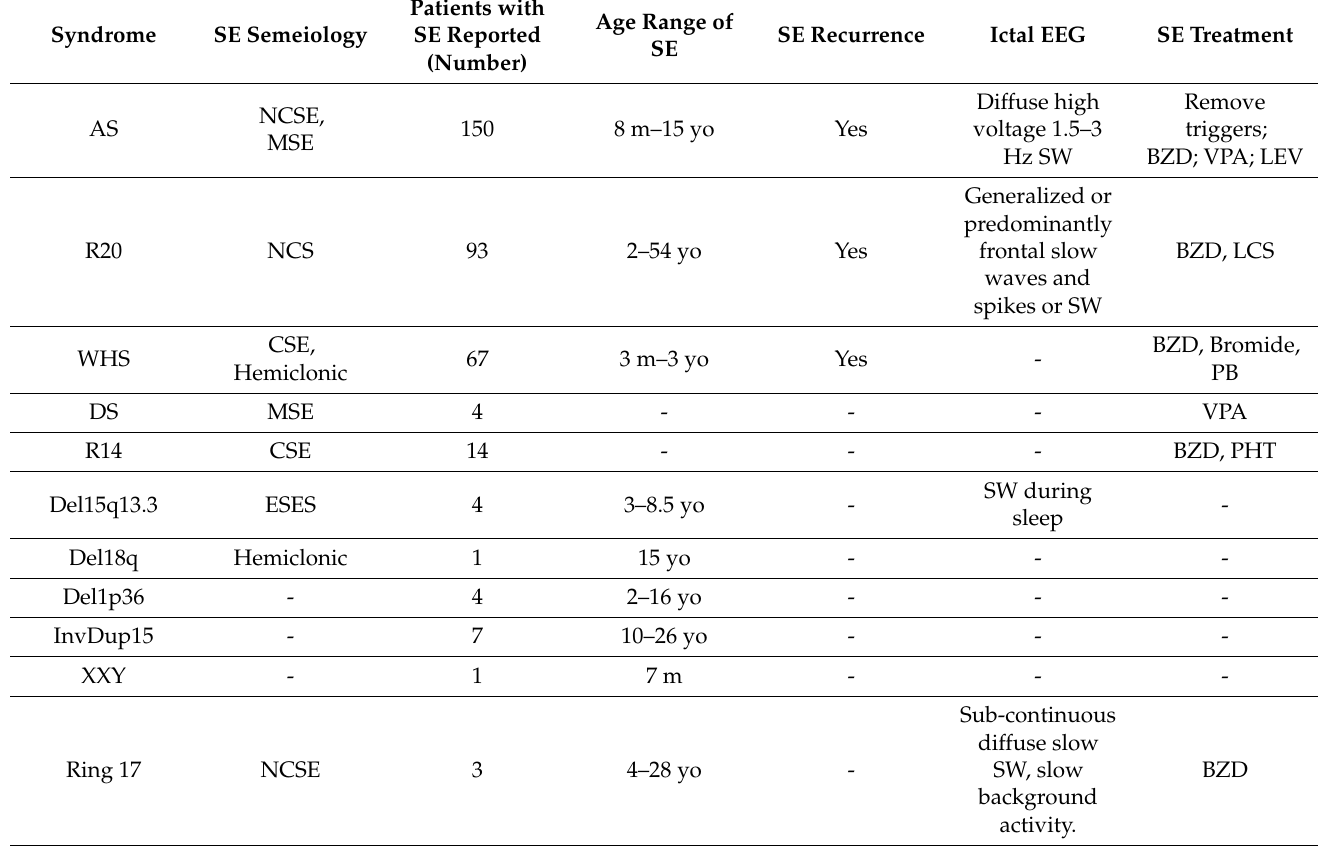
Table 8. Synoptic table. Status Epilepticus in